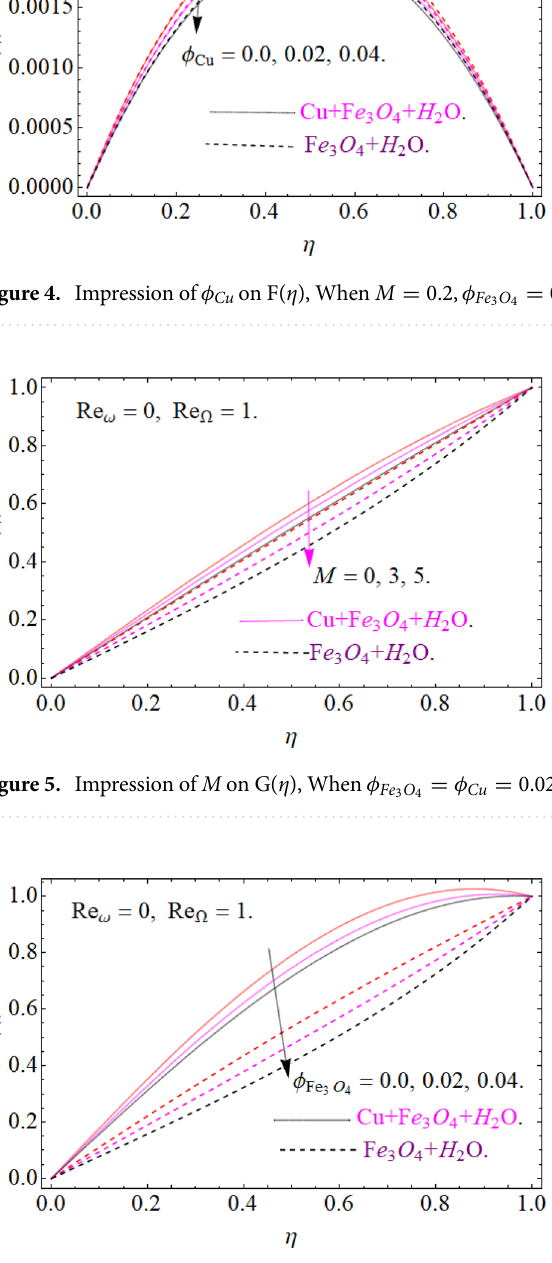
Figure 6. Impression of φ Fe 3 O 4 on G( η ), When M = 0.2, φ Cu = 0.02, Pr = 6.2